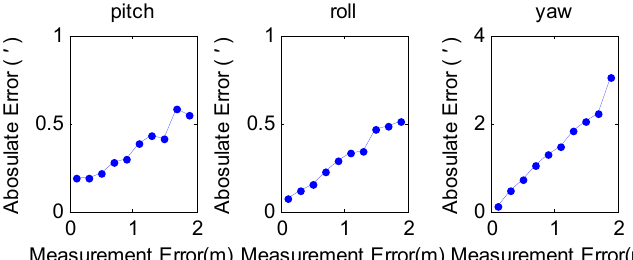
Figure 3. The boresight misalignments vs. the measurement errors.